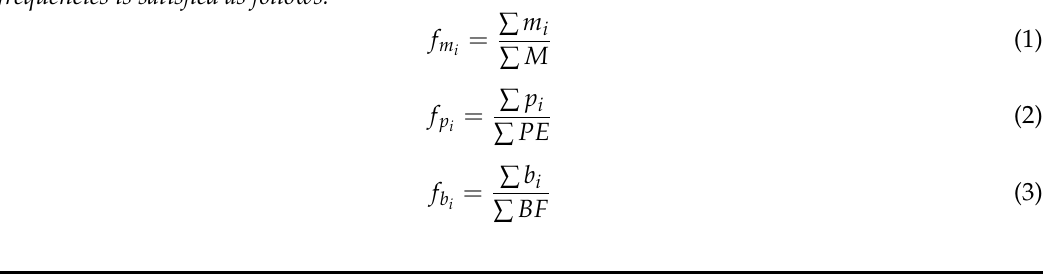
Algorithm 1: API Call List Frequency and Sequence—Computation